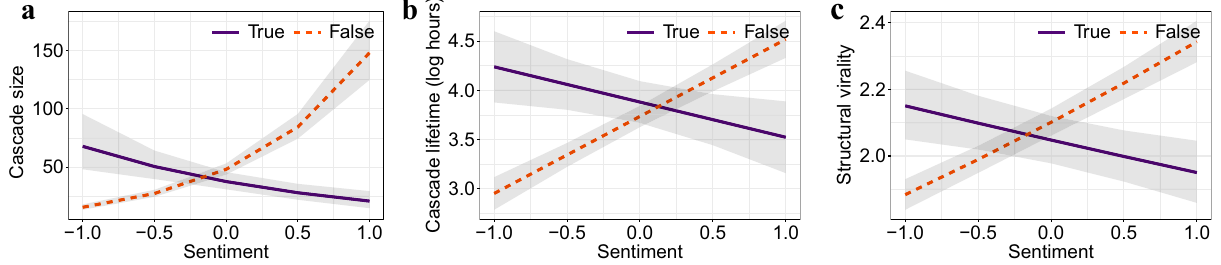
Figure 6. Predicted marginal means of cascade size ( a ), cascade lifetime ( b ), and structural virality ( c ) for different values of the sentiment variable. The 95% confidence intervals are highlighted in